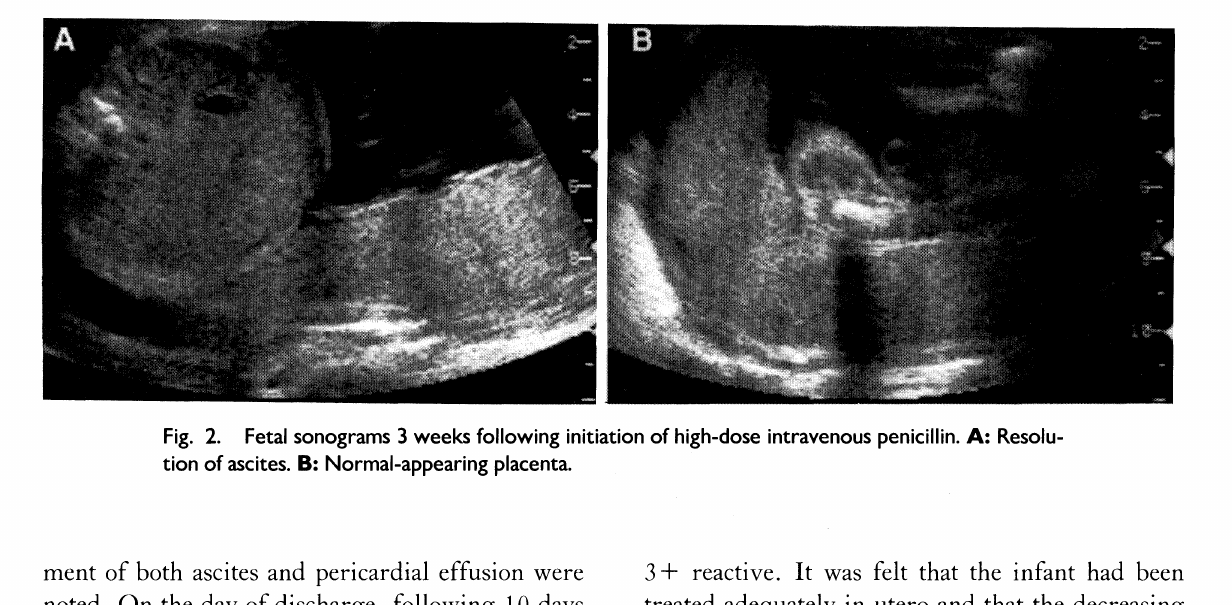
Fig. 2. Fetal sonograms 3 weeks following initiation of high-dose intravenous penicillin. A: Resolu- tion of ascites. I: Normal-appearing